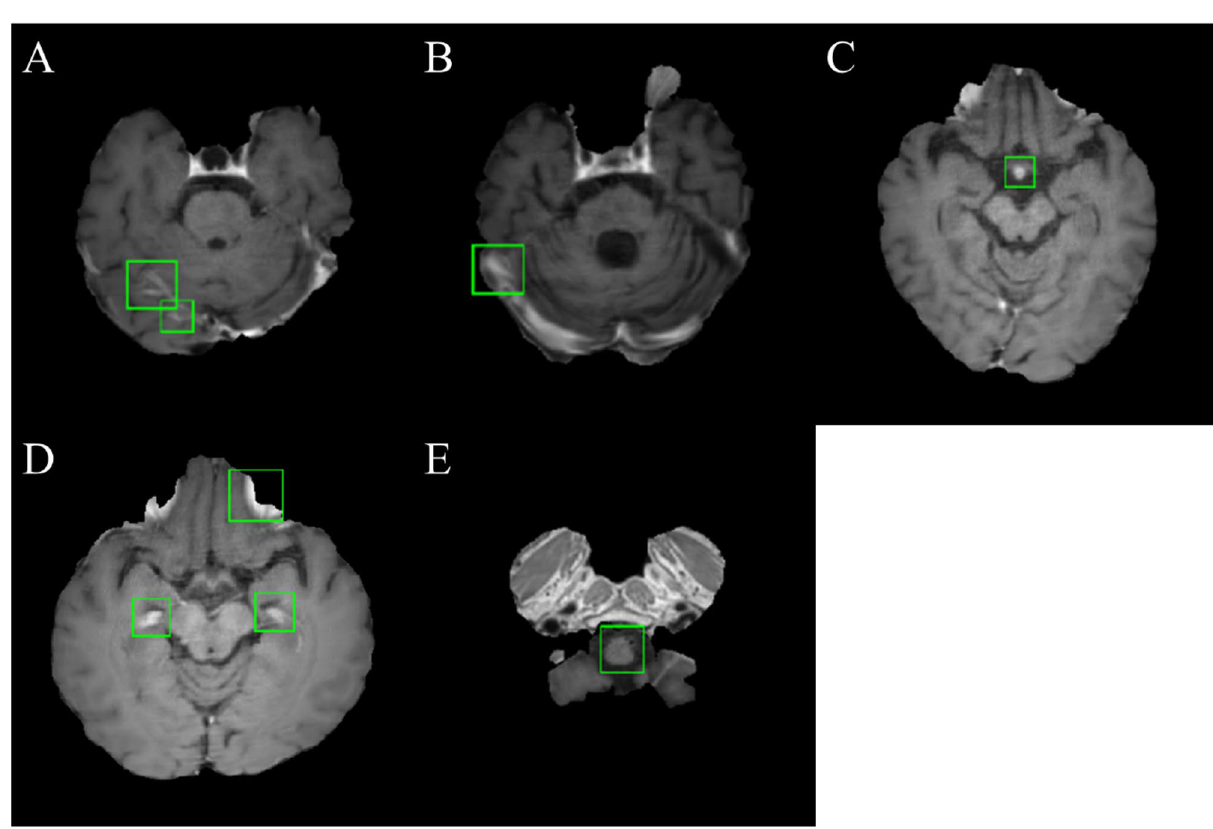
Figure 2. Examples of a typical false positive from the DLA. Sample of sampling perfection with application- optimized contrasts using different flip-angle evolution (SPACE) images demonstrated false positive regions around insufficiently suppressed vessel ( A , B ), basilar artery ( C ), choroid plexus ( D ), and medulla oblongata ( E ). False positives were overlaid with green boundary boxes. This figure was generated by MATLAB (MathWorks, R2020b, Natick, MA,